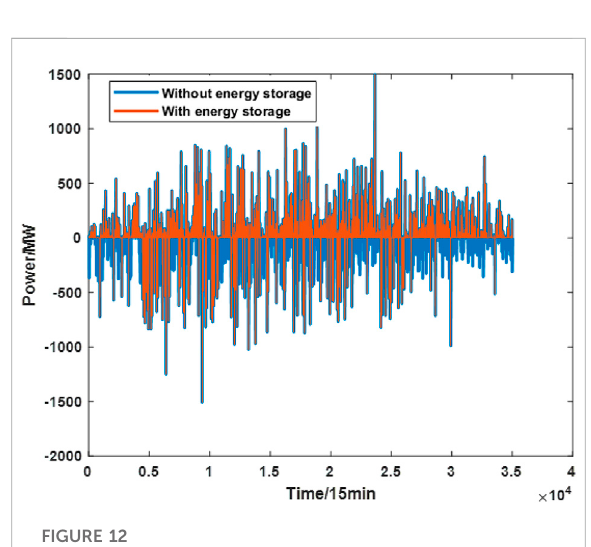
FIGURE 10 Solar curtailment power without and with energy storage.